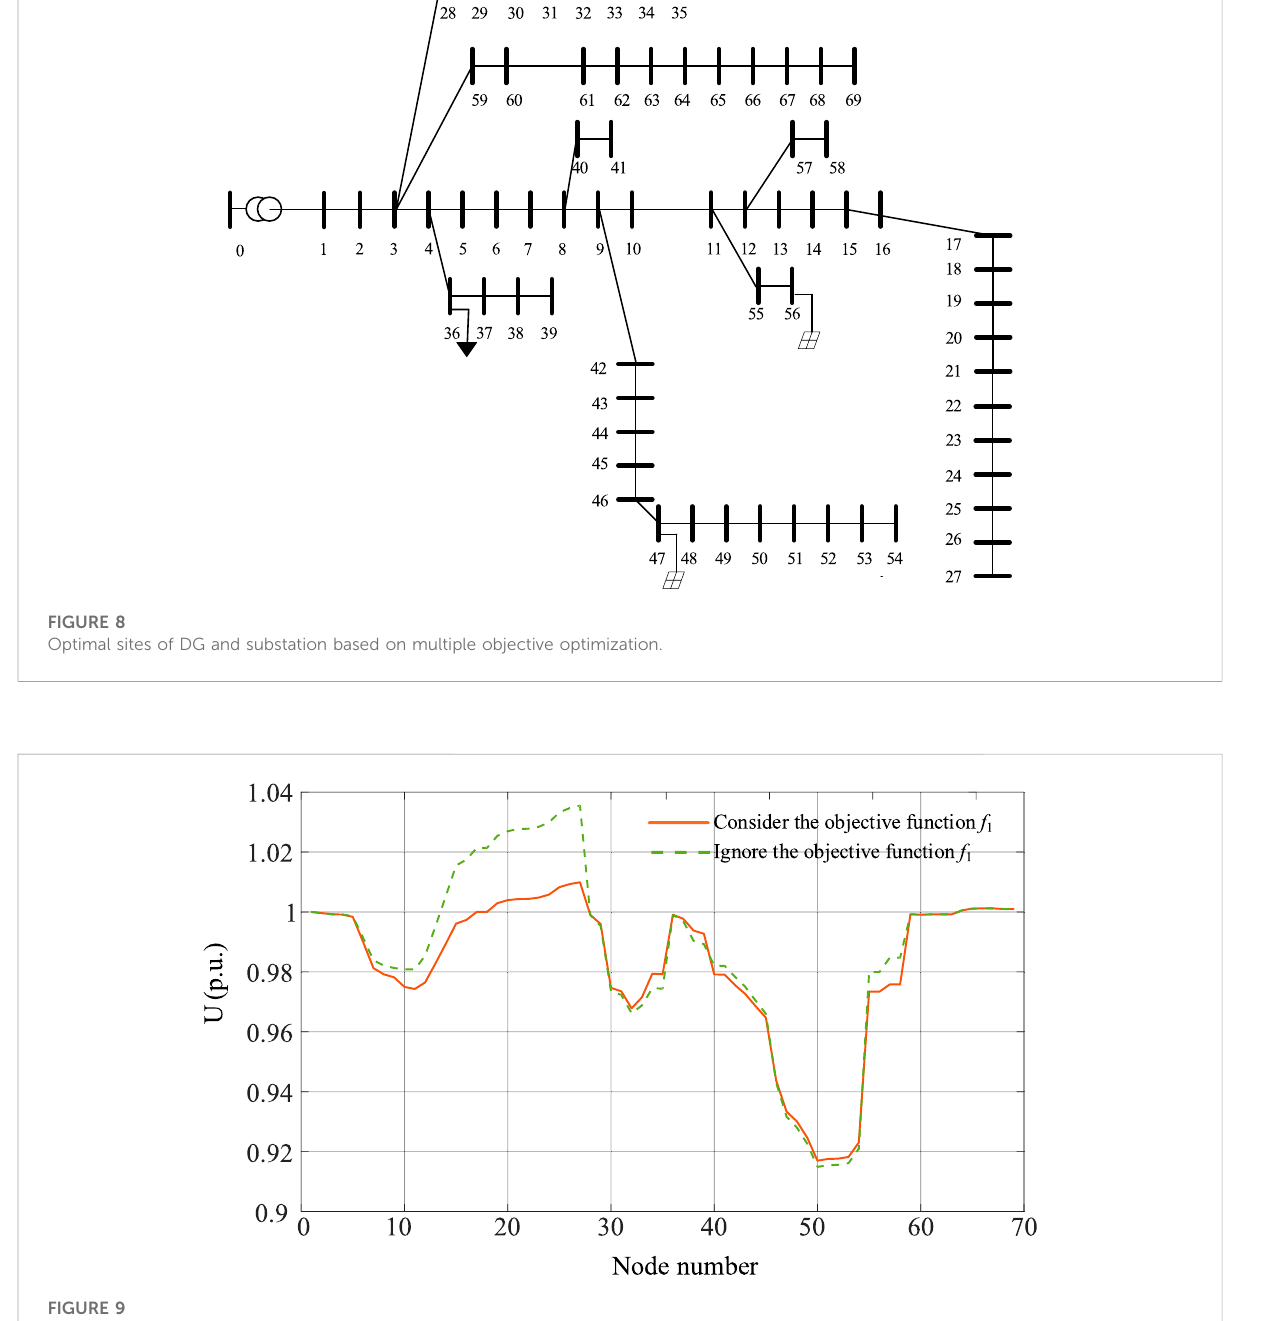
FIGURE 9 Squared node voltage in scenario one based on multiple objective